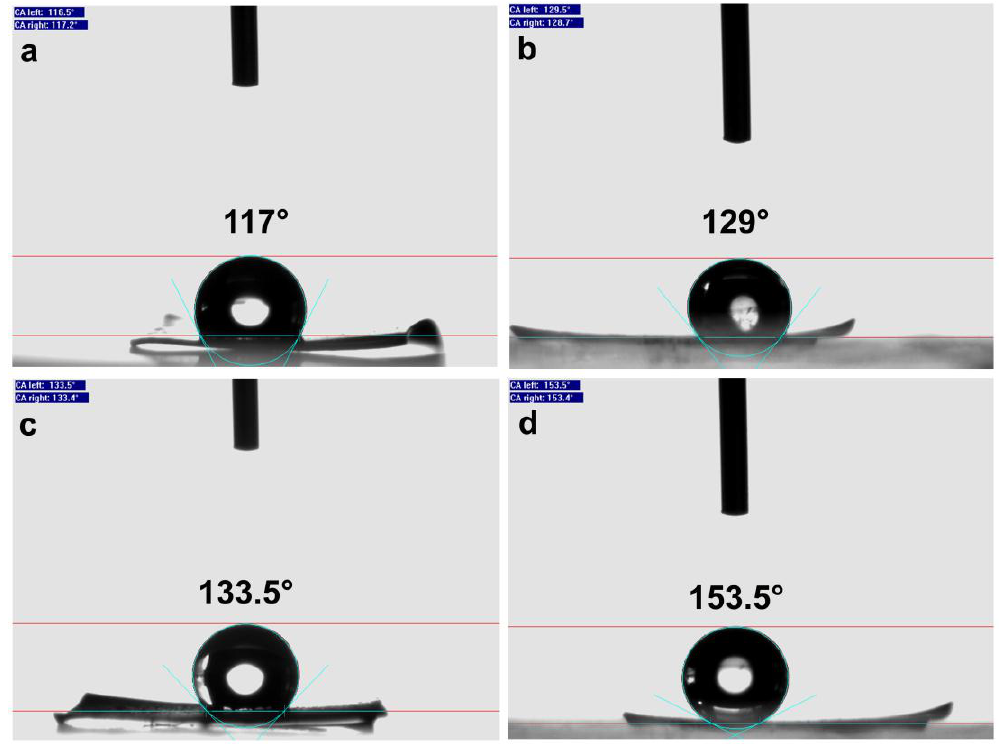
Figure 9. The shapes of a water droplet on different surfaces and the corresponding contact angle (CA) values: ( a ) modified CuO nanospheres surface; ( b ) modified underdeveloped CuO-ZnO micro-flower surfaces; ( c ) modified flat CuO-ZnO surface by SA; ( d ) modified flat CuO-ZnO surface by PDMS.